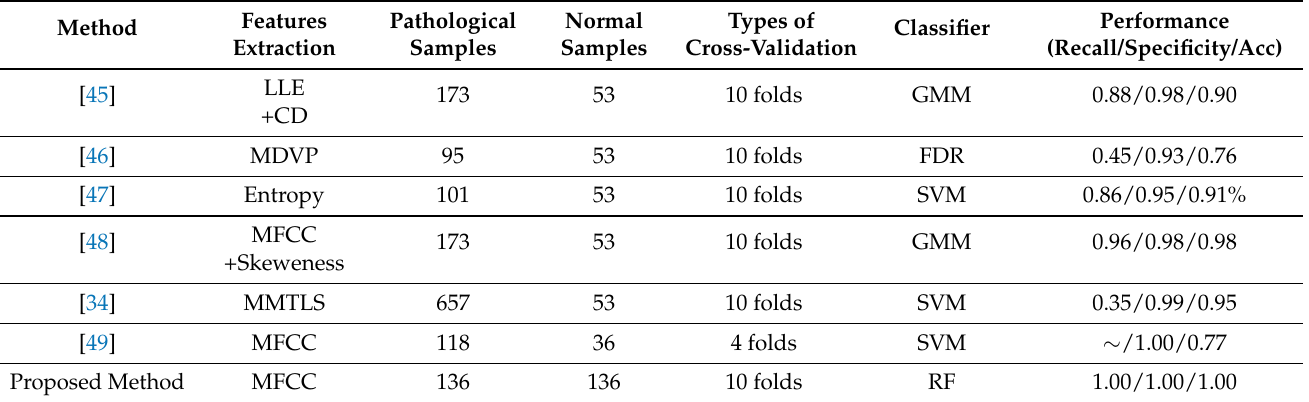
Table 14. Results of the methods in the MEEI database (binary